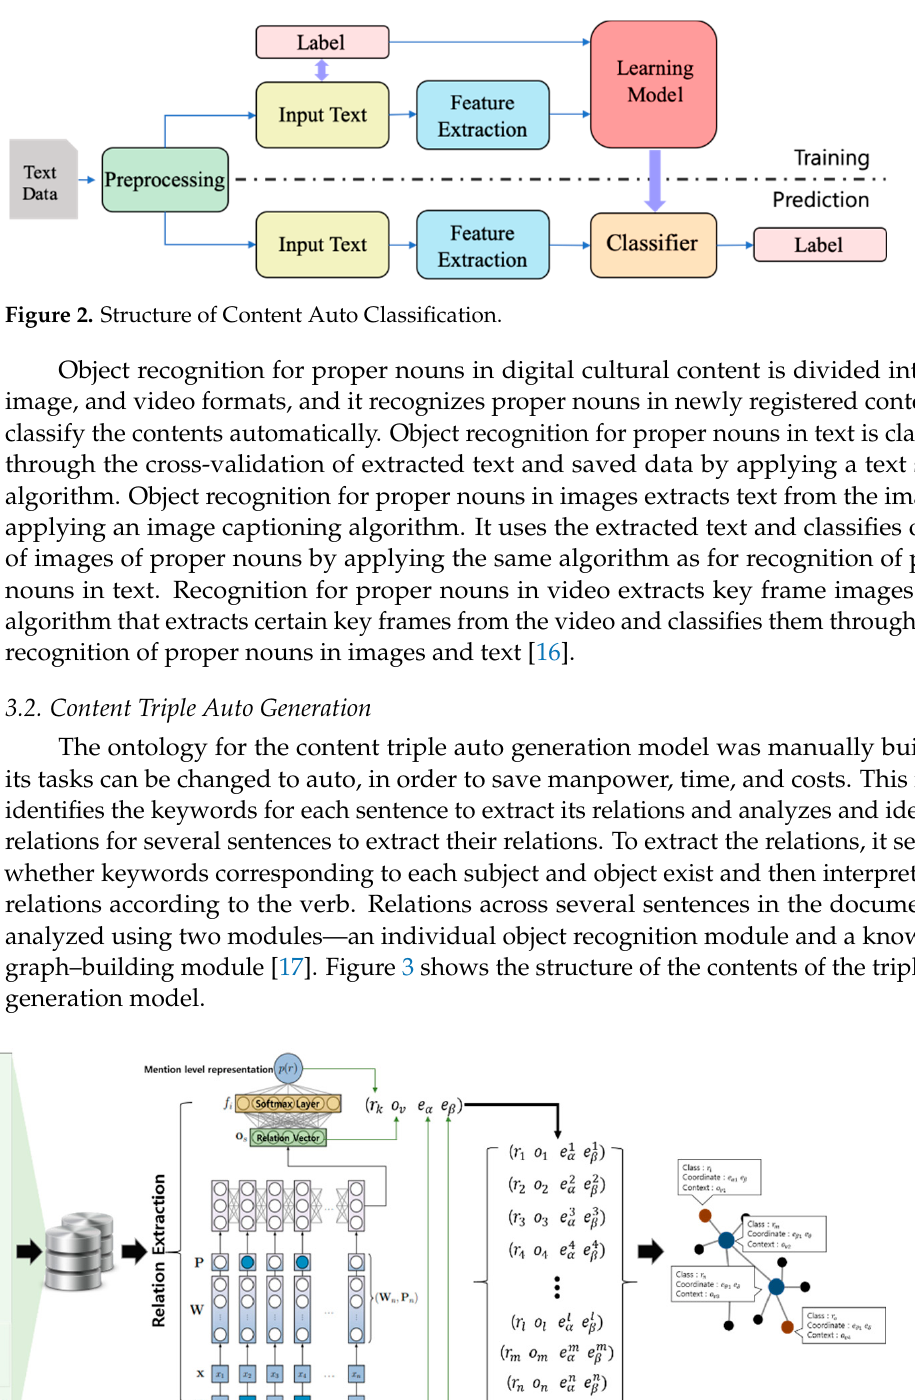
Figure 3. Structure of Content Triple Auto Generation.